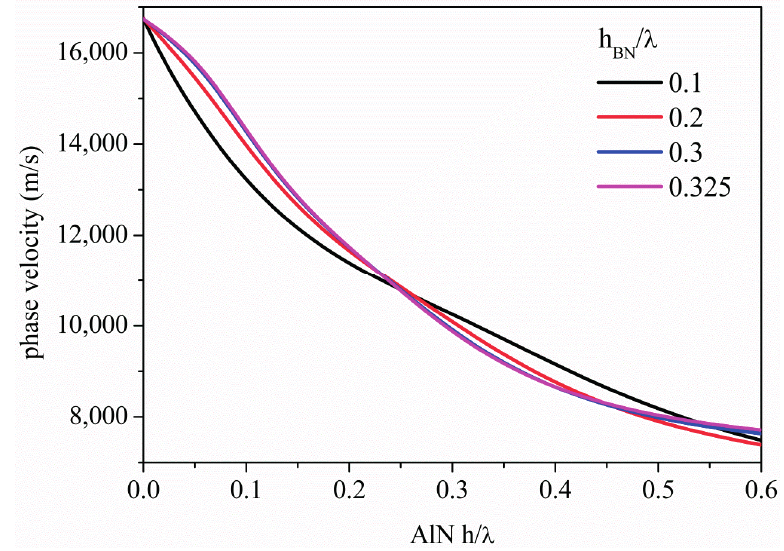
Figure 4. Phase velocity vs . AlN h/ λ of the S 0 mode along the BN/AlN composite plates, h BN / λ being the running